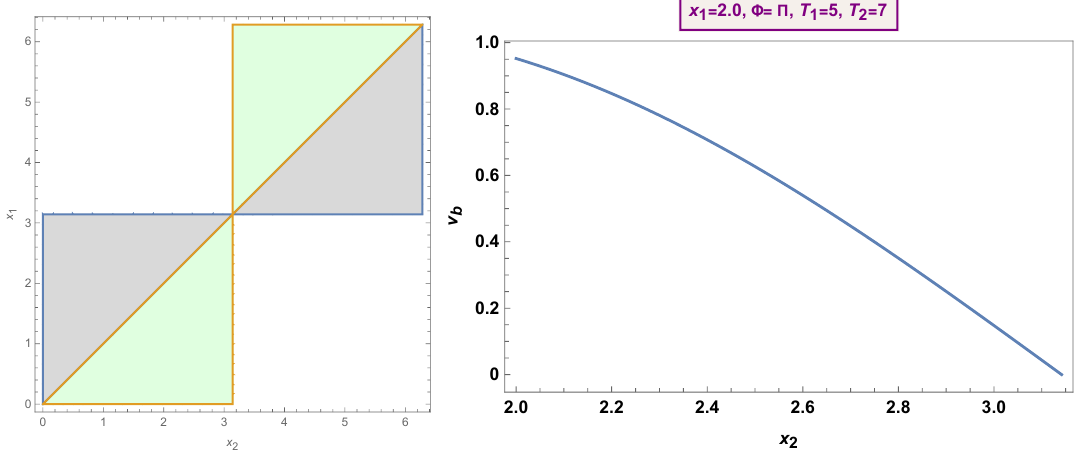
Figure 6 . Left: plot showing the allowed regions in x 1 and x 2 in discrete drive case. The green regions indicate the allowed ranges for η while the grey regions indicate that for ¯ η . Right: change in v B with x 2 when x 1 is kept fixed. All distances are scaled in units of L